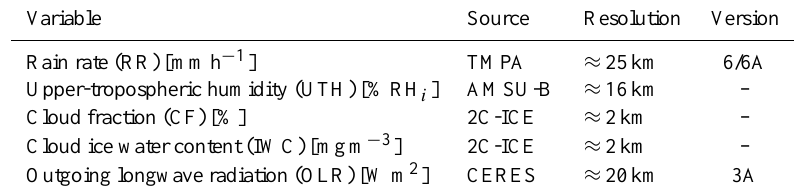
Table 1. List of the satellite data sets used in this study along with their acronyms, horizontal resolutions, and the version of the data set. Variable Source Resolution